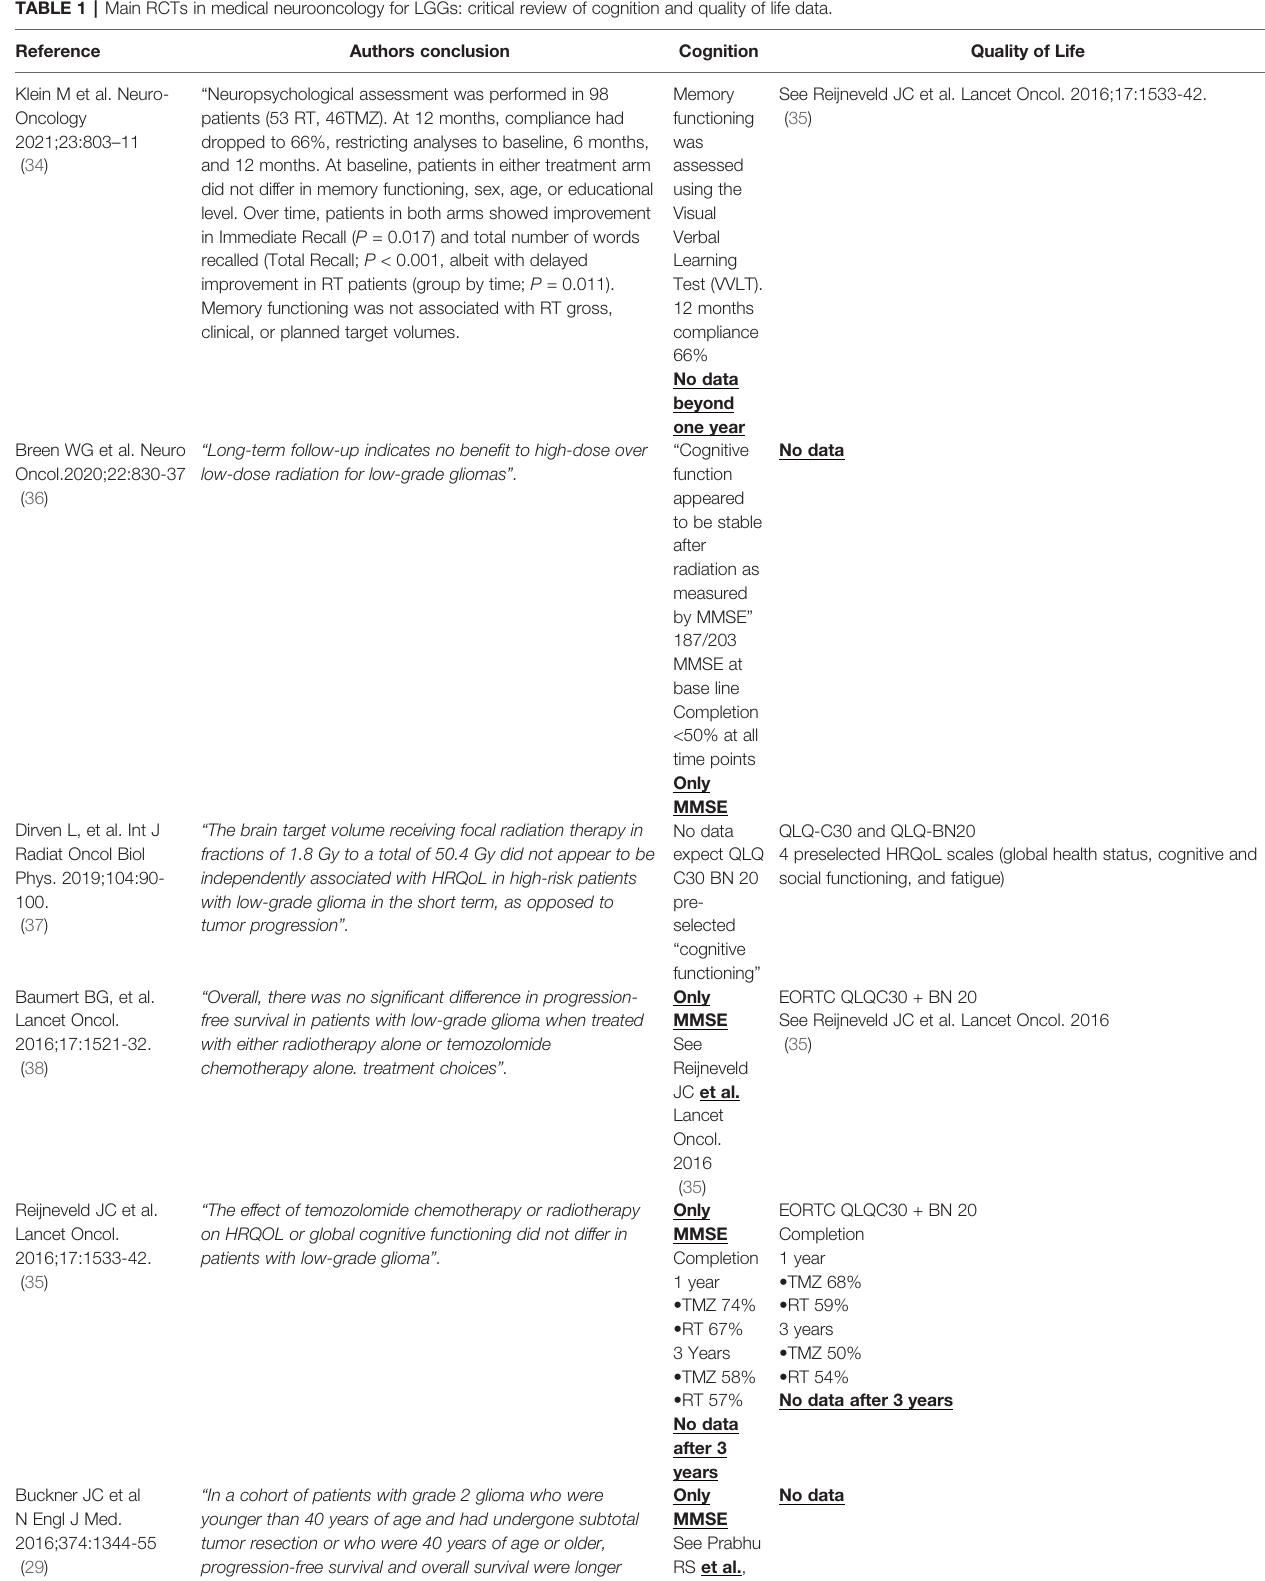
TABLE 1 | Main RCTs in medical neurooncology for LGGs: critical review of cognition and quality of life